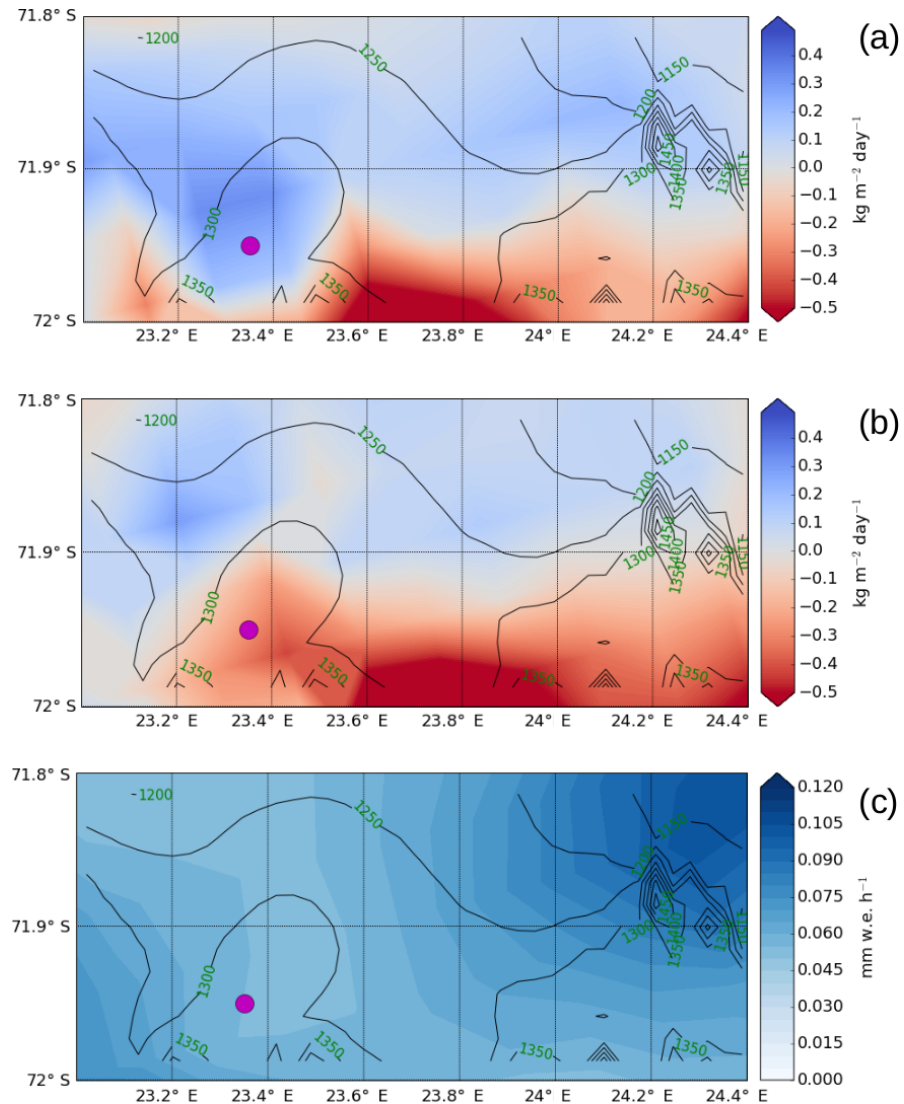
Figure 9. Wind-driven snow accumulation and ablation during the two regimes at PE: (a) accumulation regime without snowfall (SMB + , S 0) and (b) ablation regime without snowfall (SMB − , S 0); (c) average amount of snowfall during the 24h preceding both regimes. The fields are based on RACMO2.3 simulation. The purple dot indicates the location of the PE station, while the contours denote the topography in